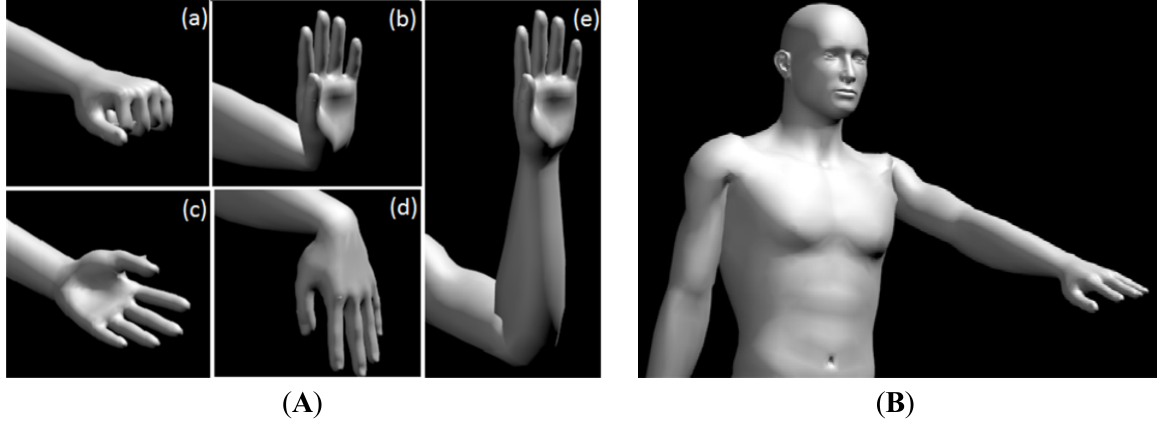
Figure 5. Details virtual model: ( A ) zoom of the hand: ( a ) hand contraction, ( b ) wrist extension, ( c ) forearm rotation, ( d ) wrist flexion, ( e ) forearm flexion e; ( B ) whole body